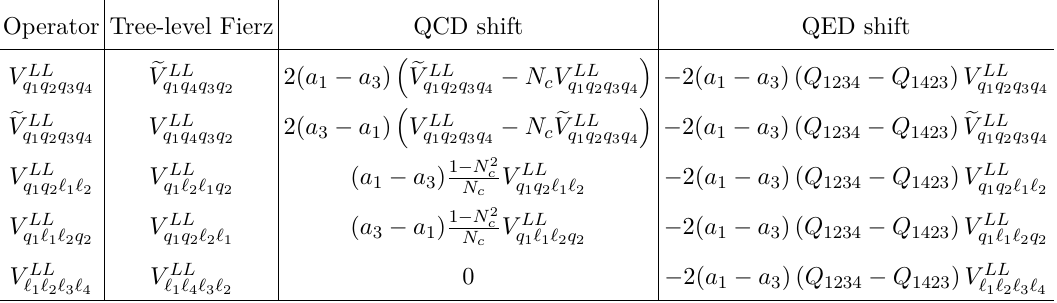
Table 7. Fierz transformations for four-quark γ µ P L ⊗ γ µ P L operators together with their one-loop QCD and QED shifts resulting from genuine vertex corrections in the generalised BMU scheme.